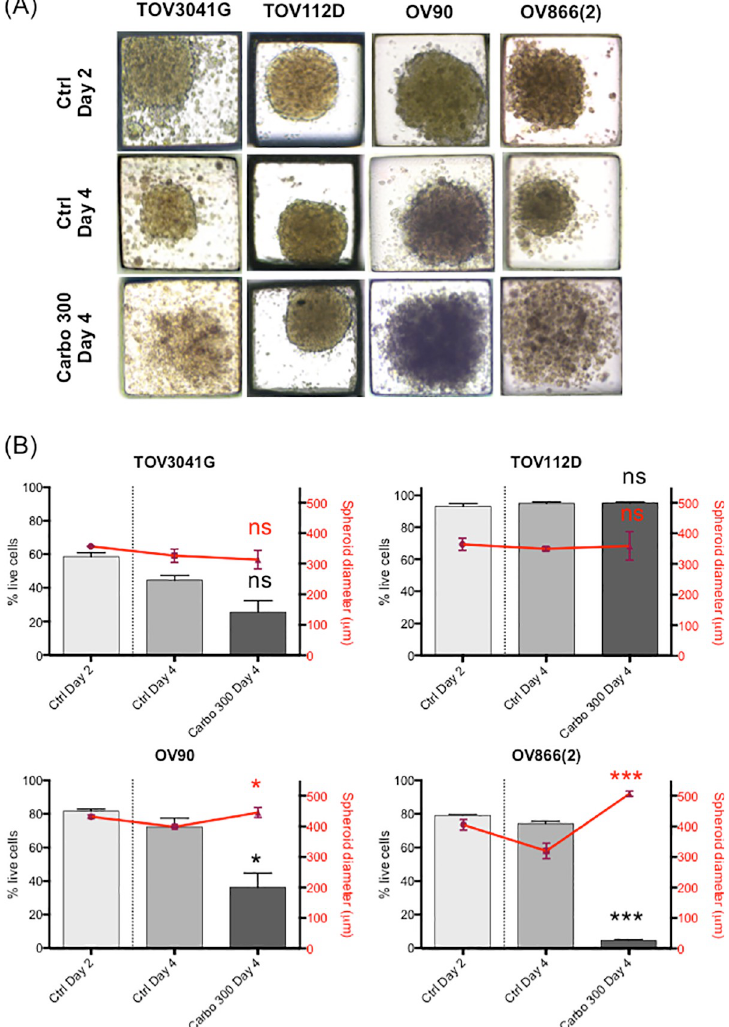
Fig 4. Carboplatin response of EOC spheroids cultured in PDMS microfluidic devices. 3D spheroids of four EOC cell lines [TOV3041G, TOV112D, OV90, OV866(2)] were formed and cultured in microfluidic devices for 2 and 4 days (Ctrl Day 2 and Ctrl Day 4) or treated at day 2 with 300 μ M of carboplatin and assessed at day 4 (Carbo 300 Day 4). A) Representative microscopic bright field images at 10X magnification. B) Comparison of carboplatin treatment on EOC cell survival (grey bars) and spheroid diameters (red points). 48 spheroids were analyzed (in duplicate) from each set of experiment readouts. Error bars indicate the standard errors of the mean (SEM) of three independent experiments. Statistical analyses: Ctrl Day 4 vs Carbo 300 Day 4, � p < 0.05; ��� p < 0.0005; ns, non-significant (Student’s